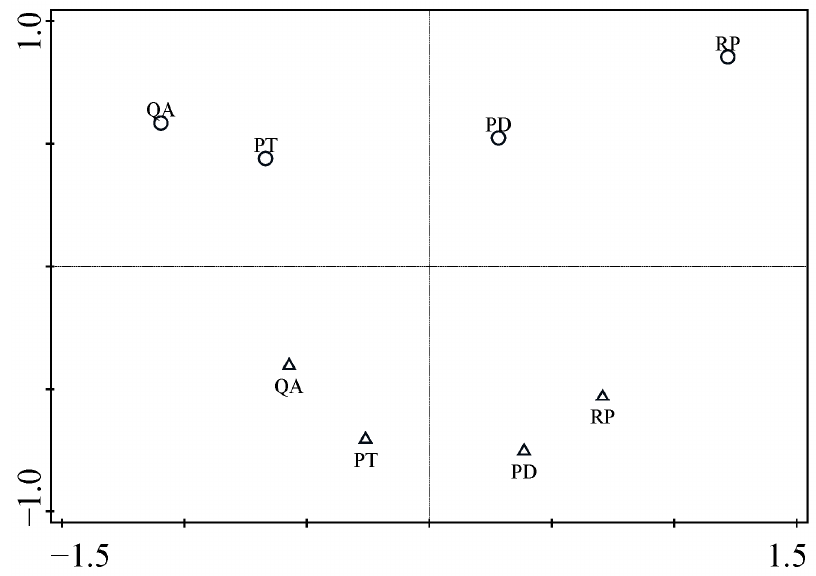
Figure 5. Nonmetric multidimensional scaling (NMDS) ordination diagram of the bacterial commu- nity structure in the litter after one year of decomposition at Mount Tai. RP: R . pseudoacacia , QA: Q . acutissima , PD: P. densiflora and PT: P . tabulaeformis . The triangles represent the leaf litter, and the circles represent the fine roots.